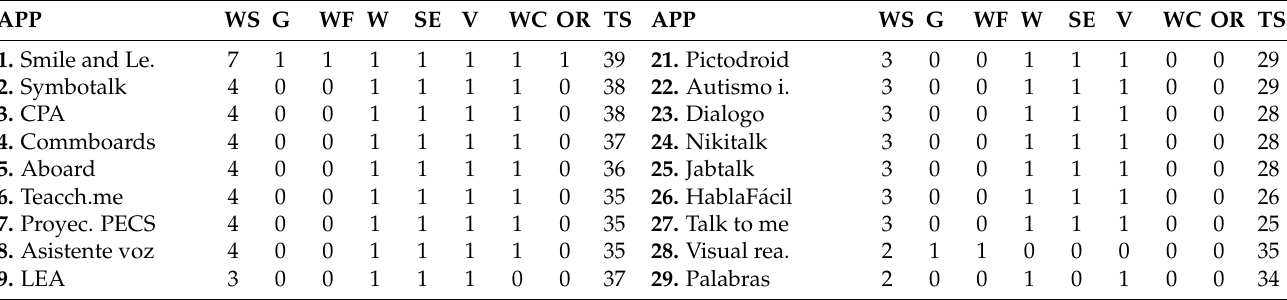
Table 7. Apps focused on writing, ordered according to the score obtained in this skill and the sub-areas it